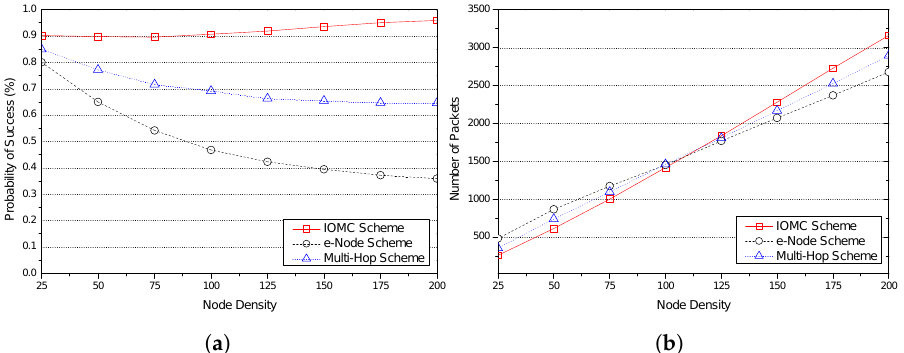
Figure 5. Plots of the performance evaluation metrics: the probability of success and number of packets against node density of various schemes. ( a ) The probability of success as a function of node density. ( b ) The number of packets as a function of node